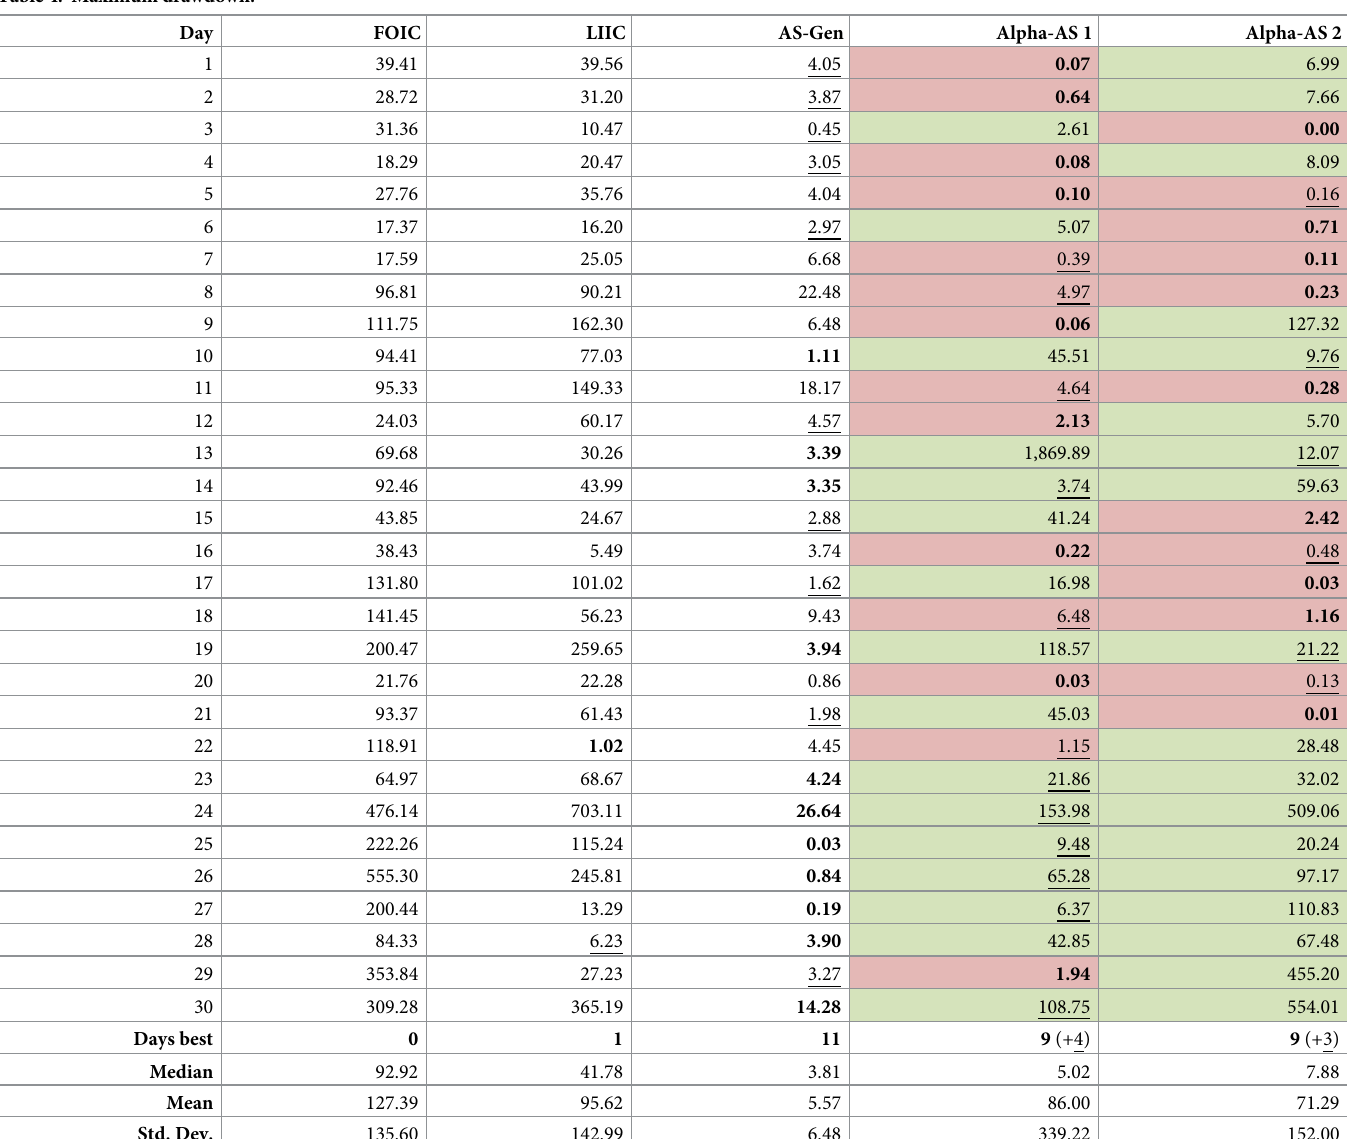
Table 4. Maximum